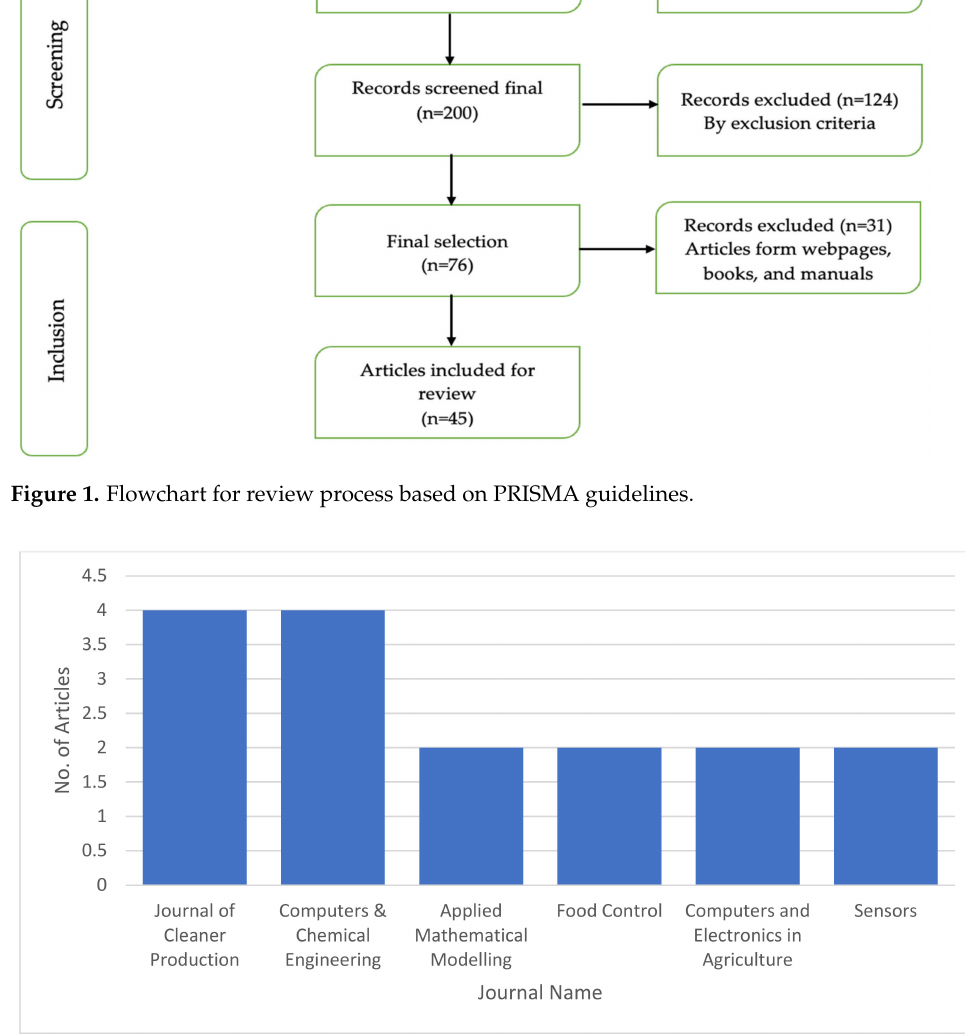
Figure 2. The number of articles per journal (if no. of articles ≥